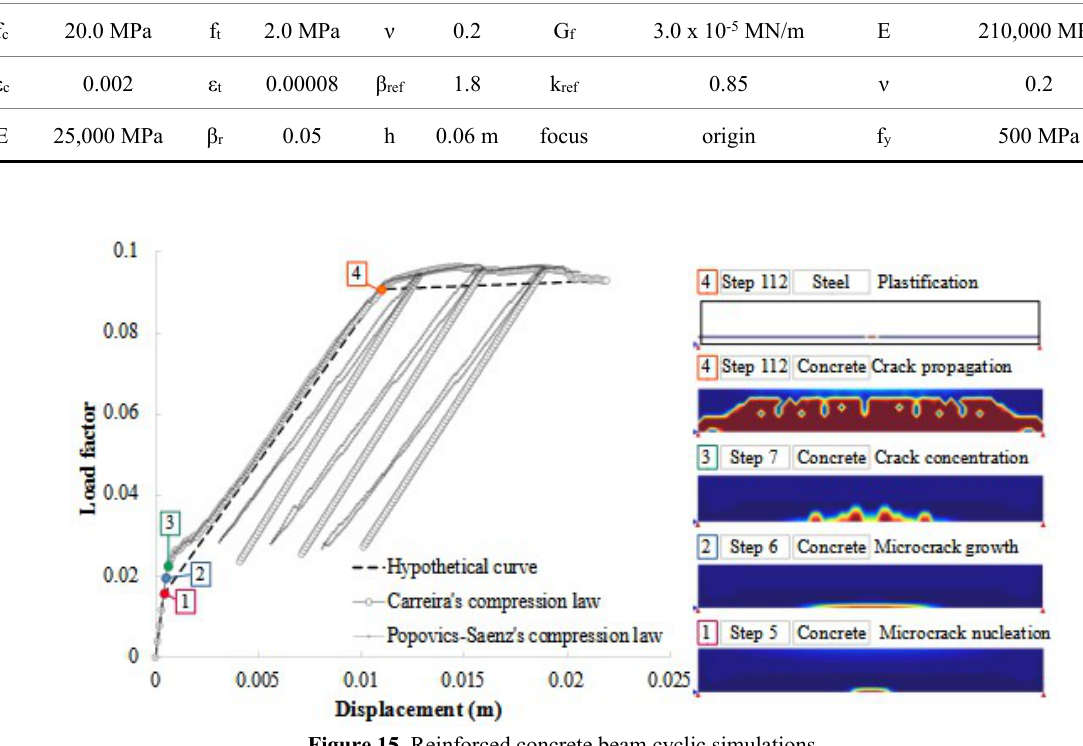
Figure 15. Reinforced concrete beam cyclic